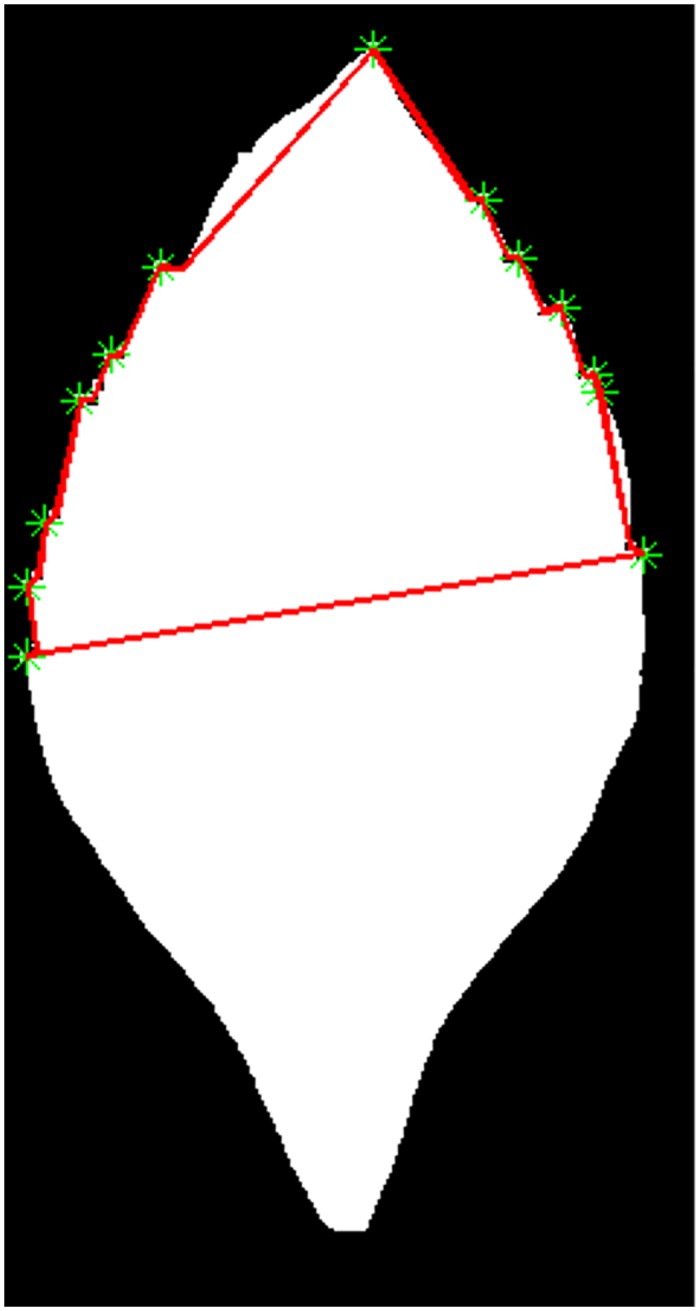
The image corners responding to leaf teeth.